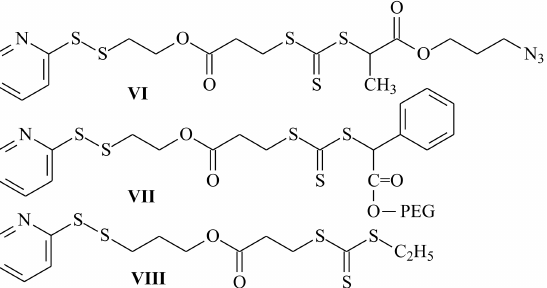
Figure 5. The structures of 3-azidopropyl-2-(2-(2-pyridyldisulfanyl)ethoxycarbonyl)ethyl dithiocar- boxysulfanyl propionate ( VI ), oligo(ethyleneglycol)phenylmethyl trithiocarbonyl propionic acid 2-dithiopyridyl-ethyl ester ( VII ), and 3-(pyridin-2-yldisulfanyl)propyl- 2-(ethylthiocarbonothioylthio) propanoate ( VIII